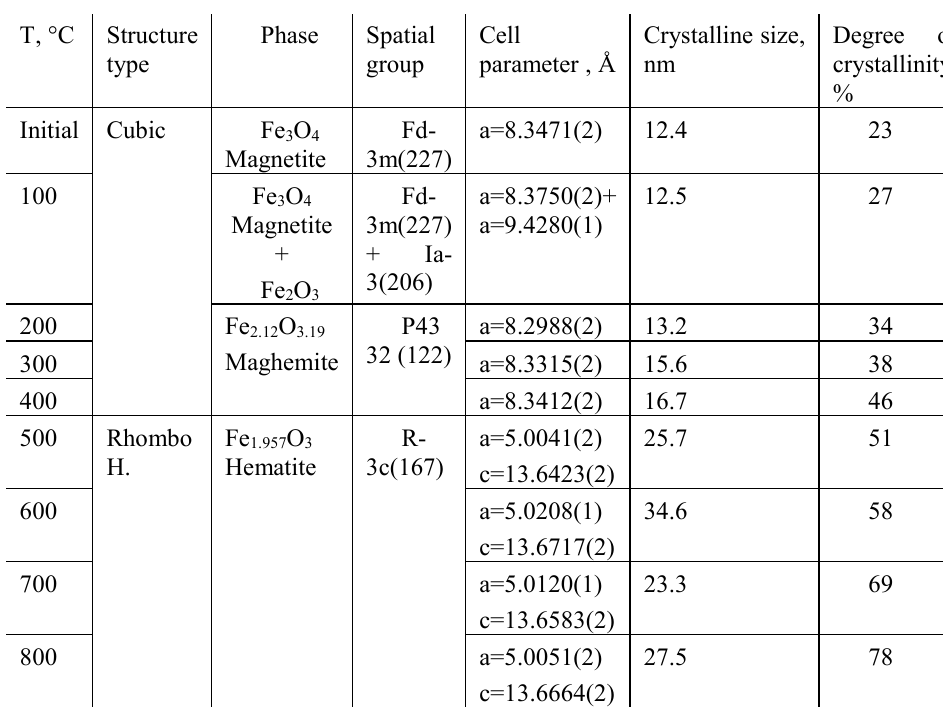
Table 1. X-ray diffraction